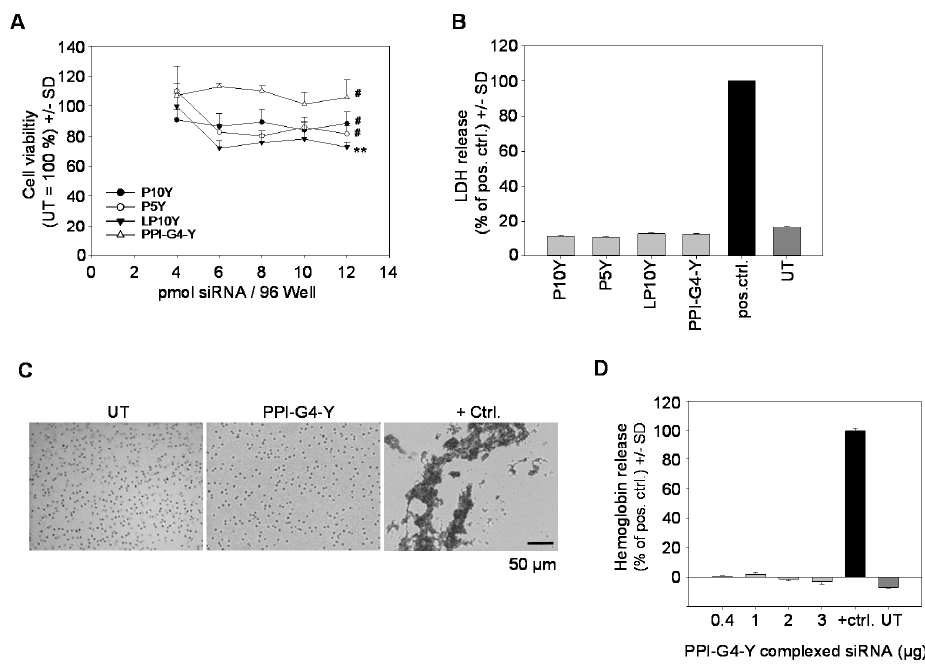
Figure 4. ( A ) Analysis of PC3 cell viability by WST-8 based measurement of viable cells